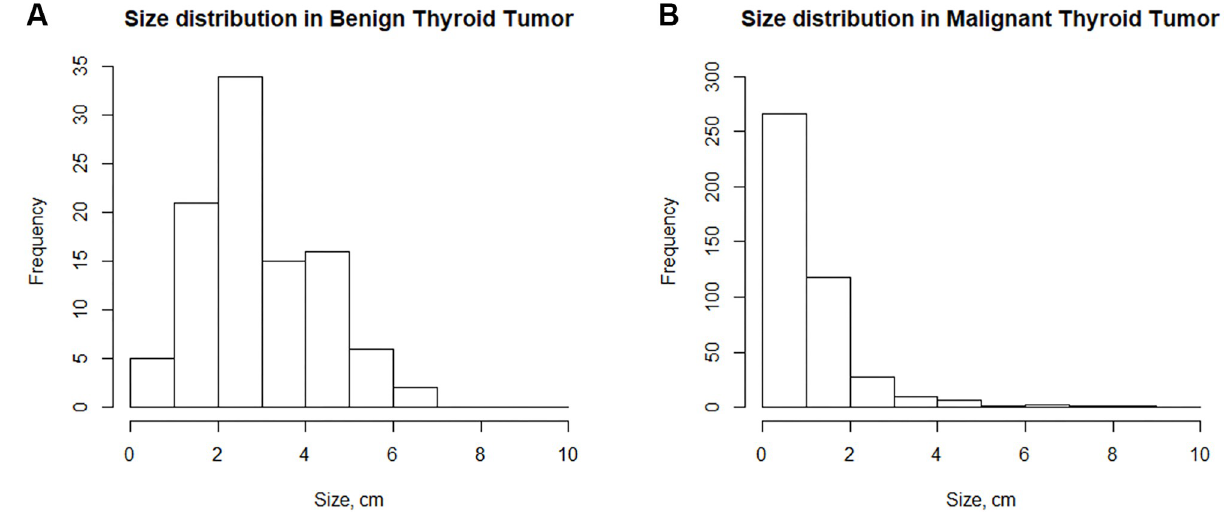
Fig 2. Size distribution of benign thyroid nodules and thyroid cancers. The median nodule size was 0.8 cm in thyroid cancers (B) and 2.8 cm in benign thyroid nodules (A). Nodule size was significantly larger in benign thyroid nodules than in thyroid cancers ( p < 0.001, Wilcoxon rank-sum test).